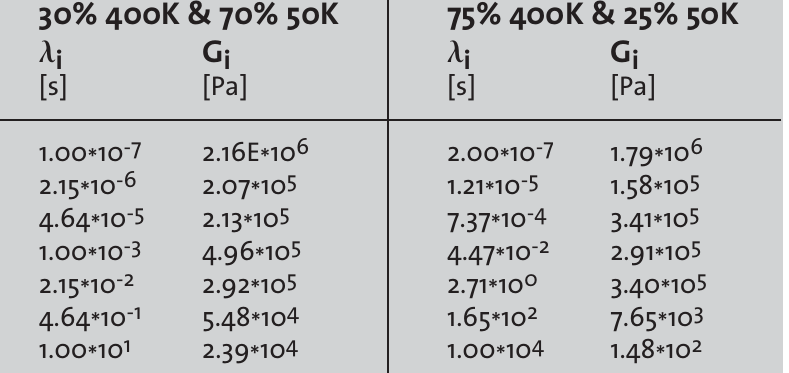
Table 2 (left above): Relaxation spectra of samples used in this work. Figure 1 (right above): MWD of 400K poly- butadiene (solid line: GPC, symbols: calculations). Figure 2 (right below): MWD of binary mixture (75% 400K + 25% 50K, solid line: GPC, symbols: